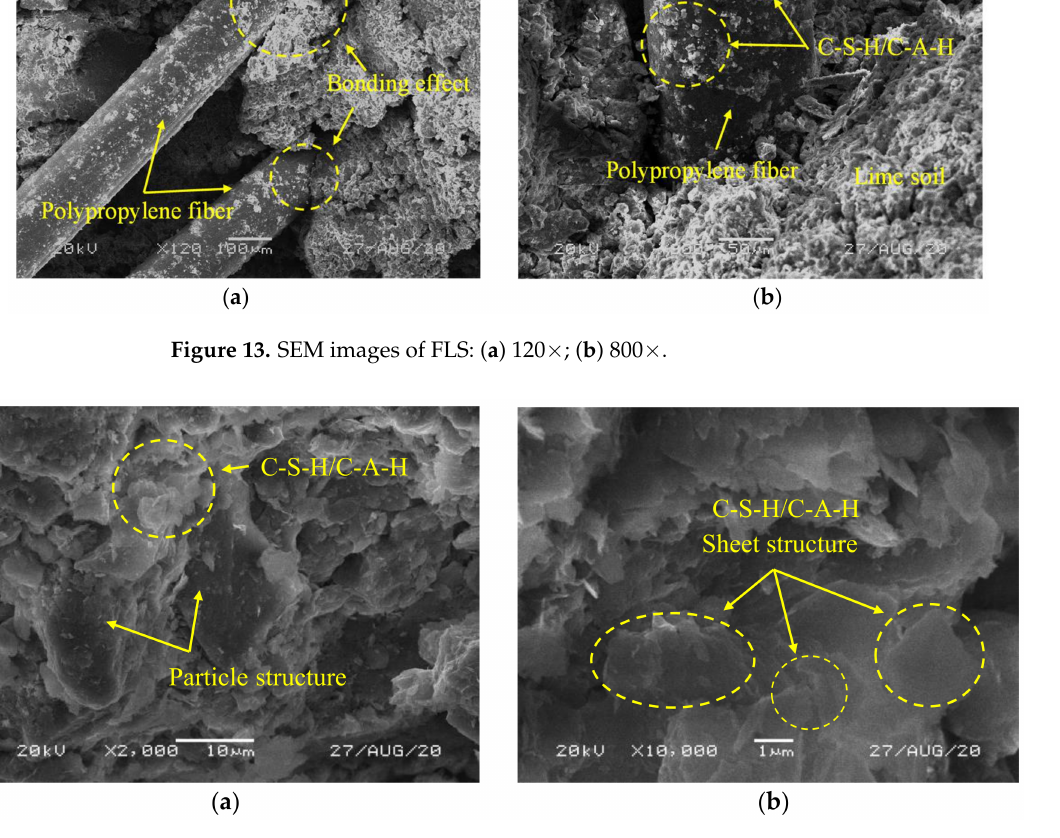
Figure 14. SEM images of NFLS: ( a ) 2000; ( b ) 10,000 ×